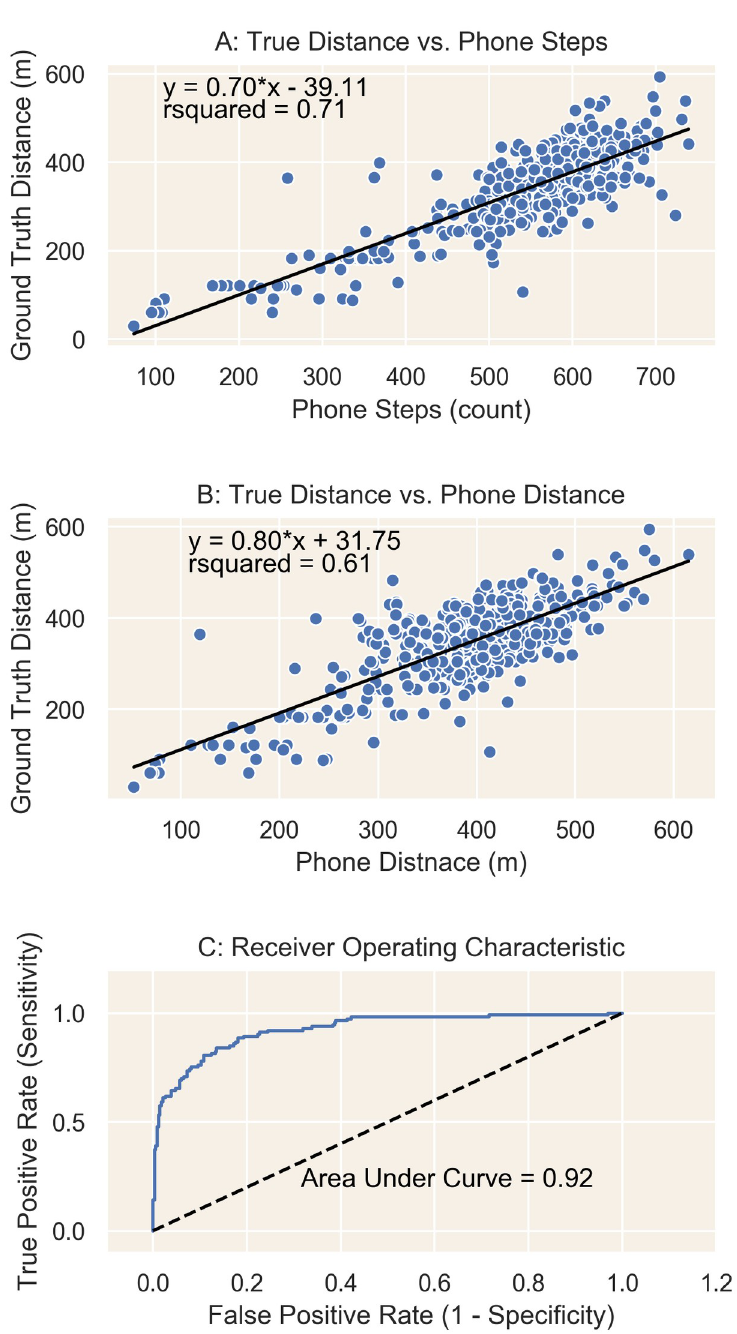
Fig 2. Accuracy of smartphone based six-minute walk test. For clinic-based six-minute walk tests, the smartphone step counts were more highly correlated with ground truth distance than was the smartphone-measured distance. When used to detect frailty as measured by ground truth distance < 300m, the smartphone performed best when incorporating both step and distance data.